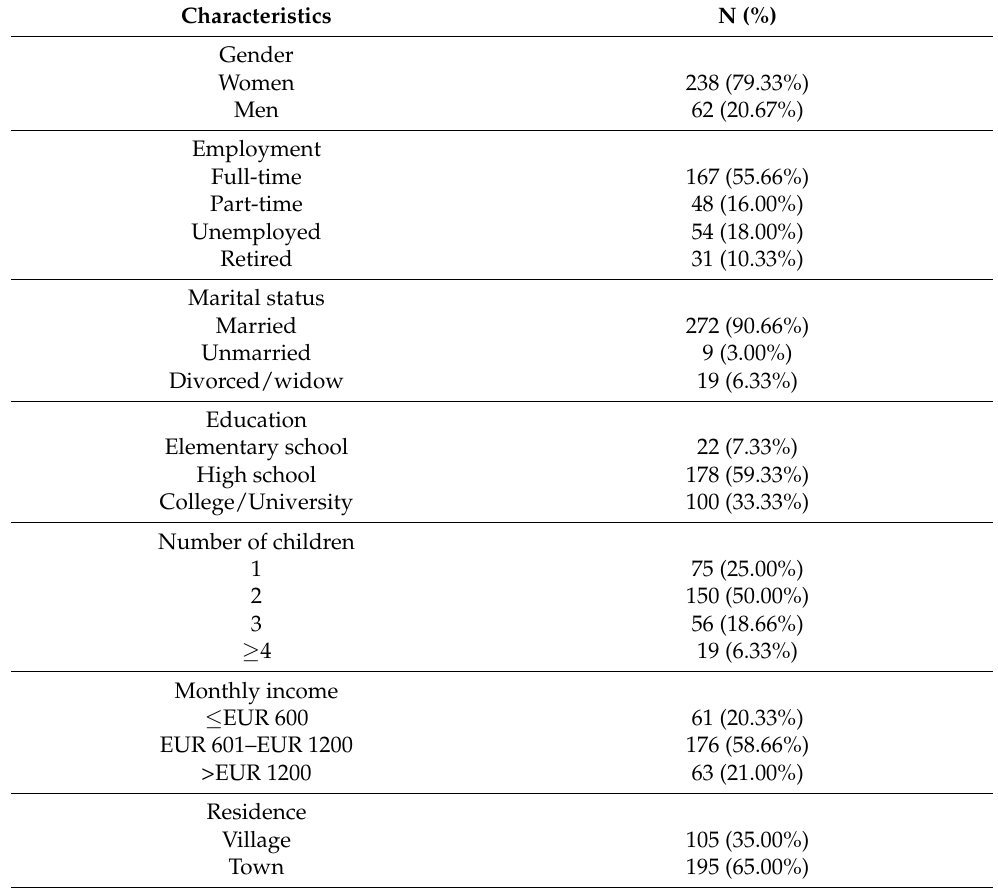
Table 1. Sociodemographic data of the